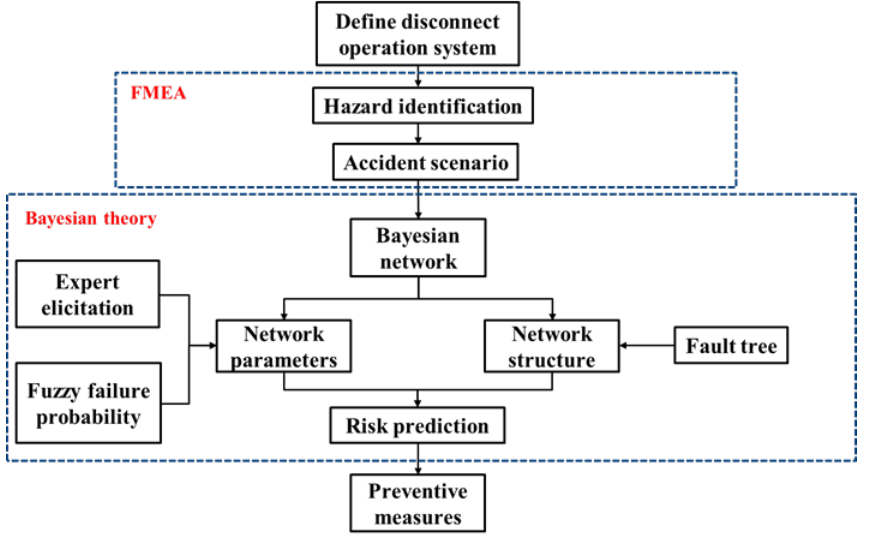
Figure 4. Flow chart of risk analysis for disconnect operations.